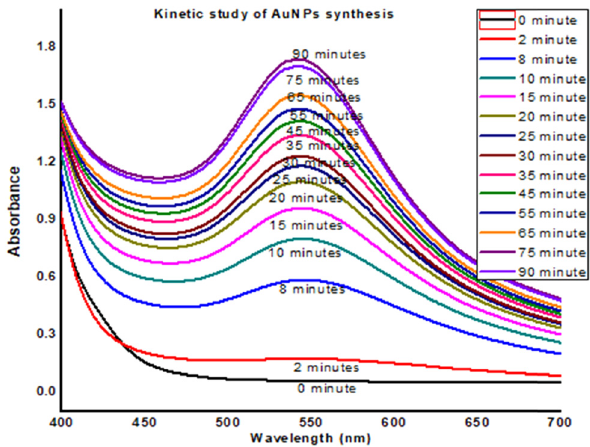
Figure 4: UV - Visible data of kinetic study of AuNPs of sa ff ron stigma ( SS - AuNPs ) .